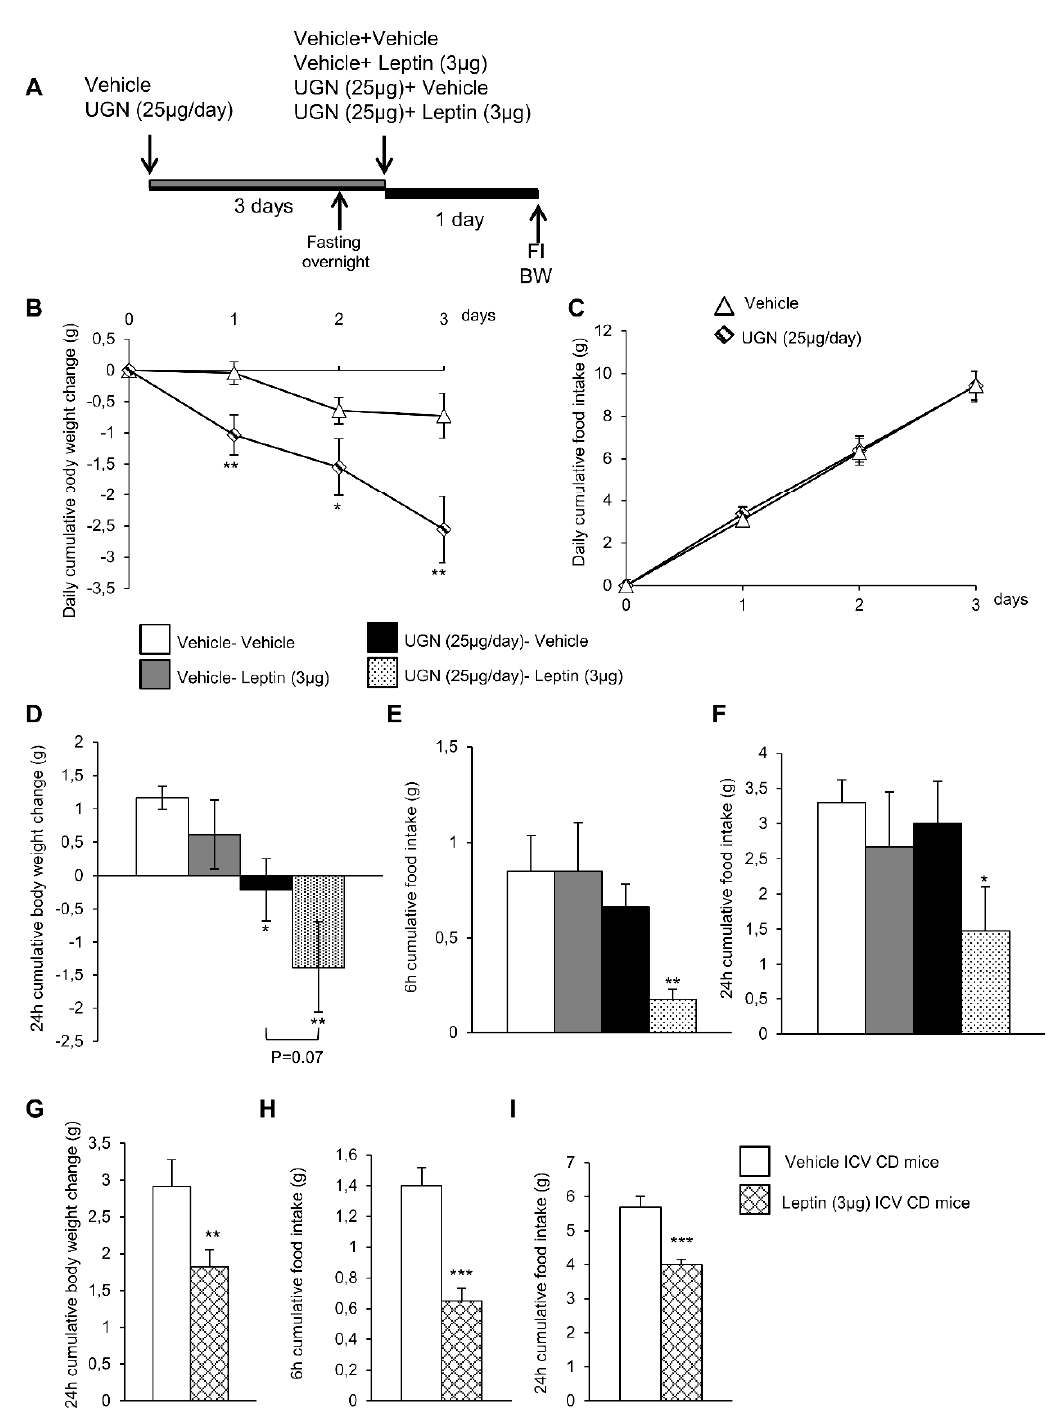
Figure 1. Schematic representation of the in vivo protocol ( A ). Effect of chronic Intracerebroventricular (ICV), uroguanylin (UGN) (25 µ g/mouse) injection for four days in DIO mice on body weight (BW) ( B ) and food intake (FI) ( C ). Effect at 24 h of ICV leptin injection (3 µ g/mouse) (the mice being pretreated with UGN (25 µ g/mouse/four days) and submitted to fasting the night before leptin injection) body weight ( D ), and food intake at 6 h ( E ) and 24 h ( F ). Effect at 24 h of ICV leptin injection (3 µ g/mouse) in lean mice fed a chow diet ( C , D ) on body weight ( G ) and food intake after 6 h ( H ) and 24 h ( I ). Values are represented as mean ± standard error of the mean (SEM); n = 8–17 animals per group. * p < 0.05; ** p < 0.01; *** p < 0.001 vs. vehicle.